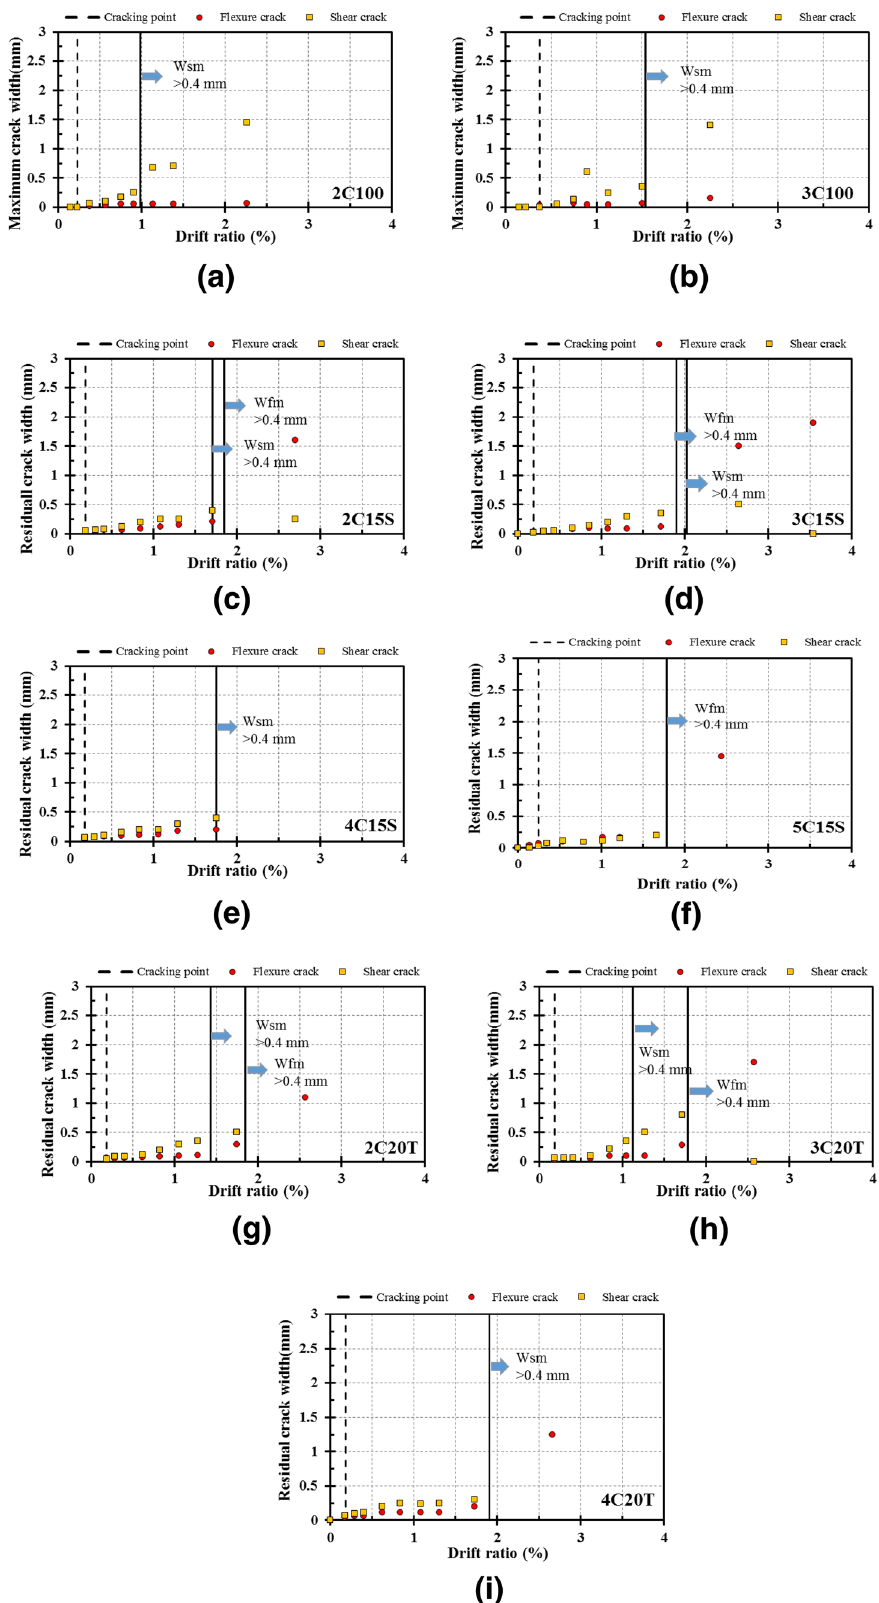
Fig. 13 Relationship between the residual maximum crack width and drift ratio of member at the peak deformation